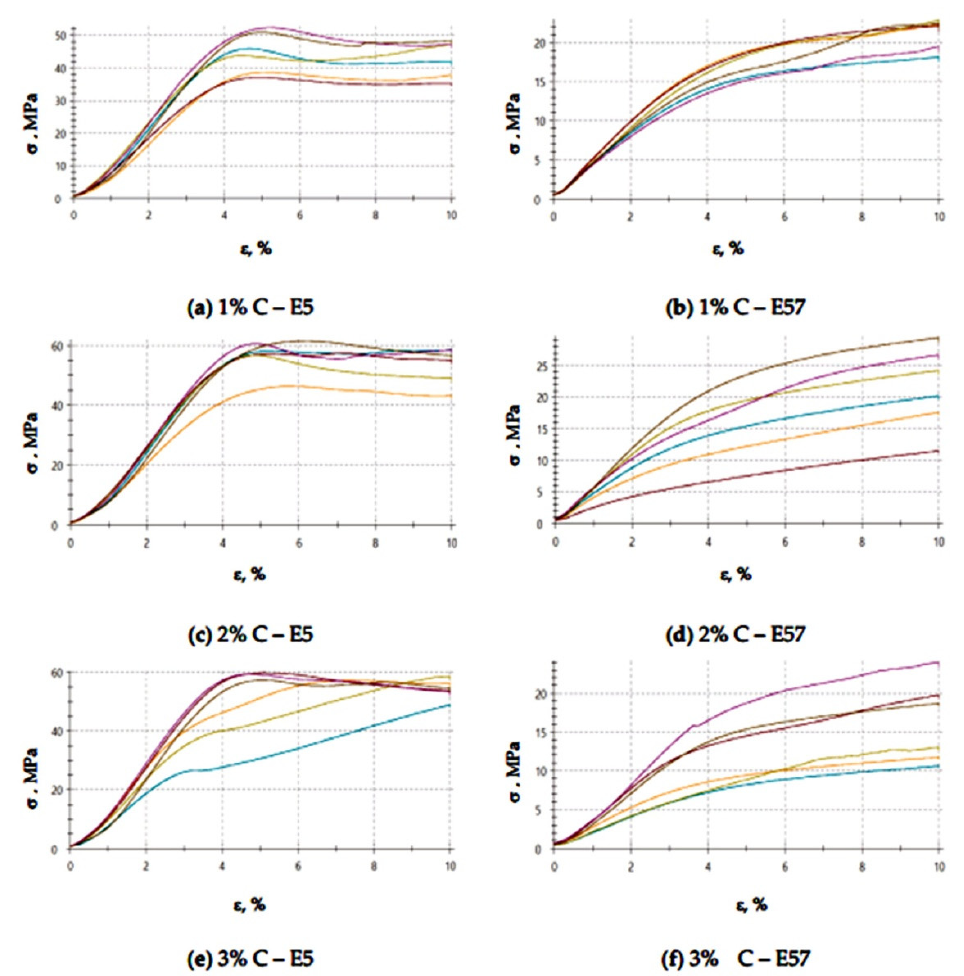
Figure 26. Stress–strain curves of the E5 / PAC / 100:80 and E57 / PAC / 100:80 epoxy specimens modified by the activated carbonate filler post-thermal shock chamber aging: ( a ) 1% C—E5, ( b ) 1% C—E57, ( c ) 2% C—E5, ( d ) 2% C—E57, ( e ) 3% C—E5, ( f ) 3% C—E57.